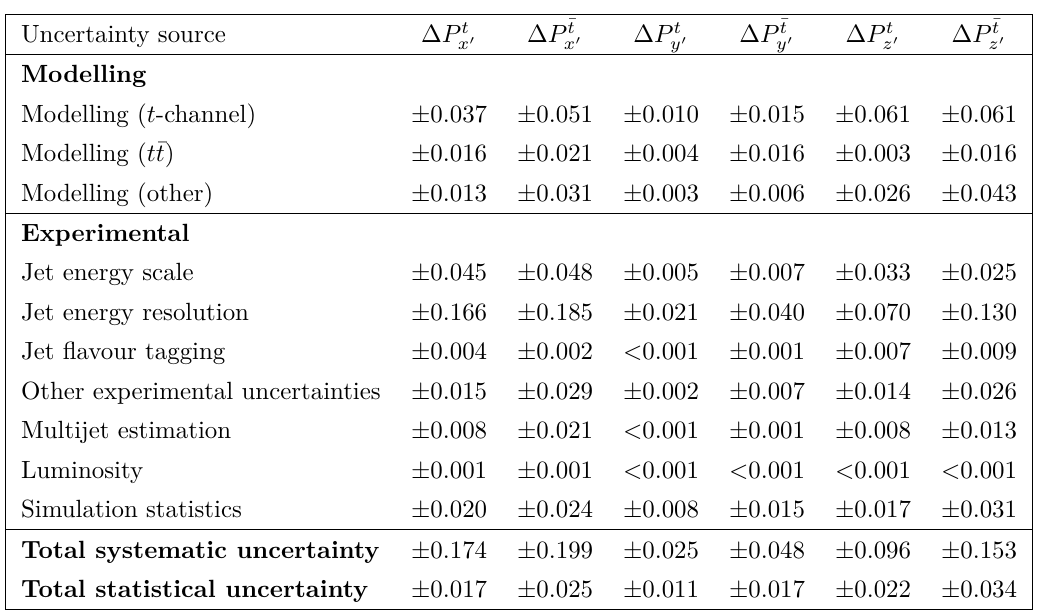
Table 5 . Systematic and statistical uncertainties in the measurement of the polarisation vector ~P for top quarks and top antiquarks. The impact of each group of uncertainties is obtained by performing a fit where the NPs in the group are fixed to their best-fit values, subtracting the square of the resulting uncertainty in the parameter of interest (i.e. for each polarisation component) from the squared uncertainty from the nominal fit, and then taking the square root. An additional uncertainty from the JER is included, consisting of the difference between the central values of the nominal fit model and the alternative fit model in which JER variations are implemented coherently across all bins of the octant variable distribution. The total systematic uncertainty is calculated as the sum in quadrature of the individual grouped